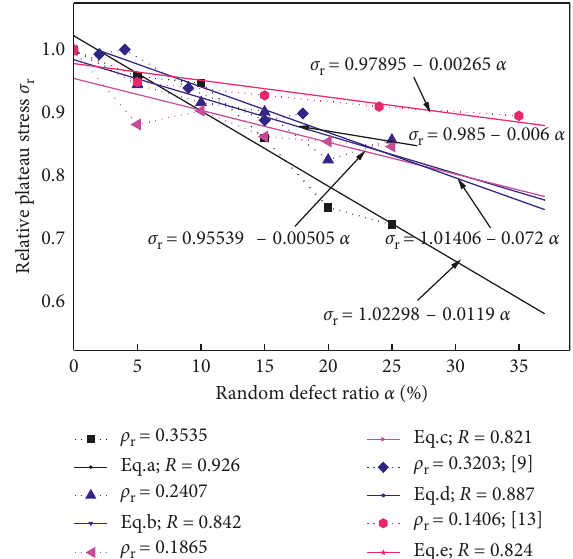
Figure 5: Effect of random defect ratio on the plateau stress.